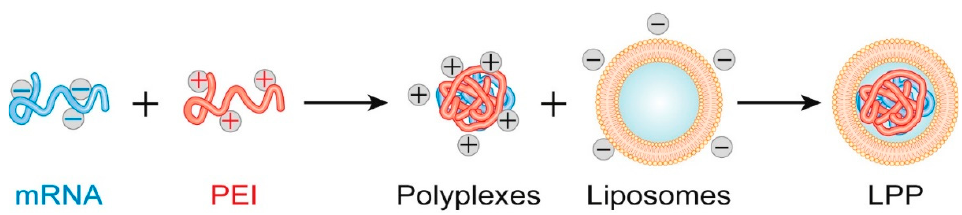
Figure 5. Schematic representation of lipopolyplexes formation. Adapted from [131], published by Cell Press, 2019.